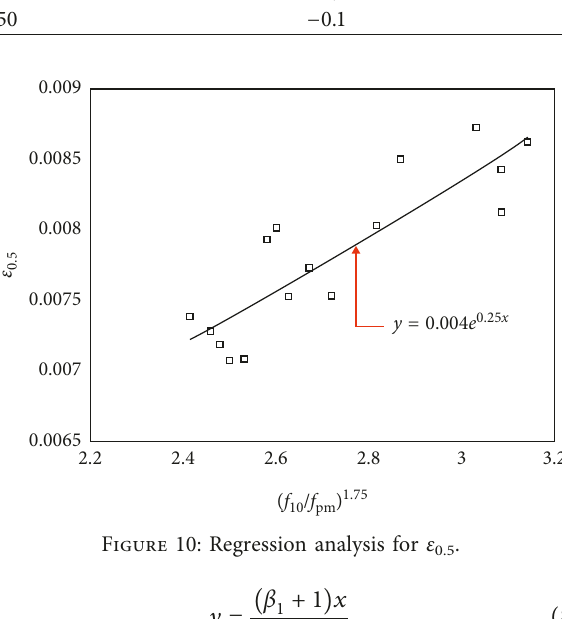
pm with existing models.